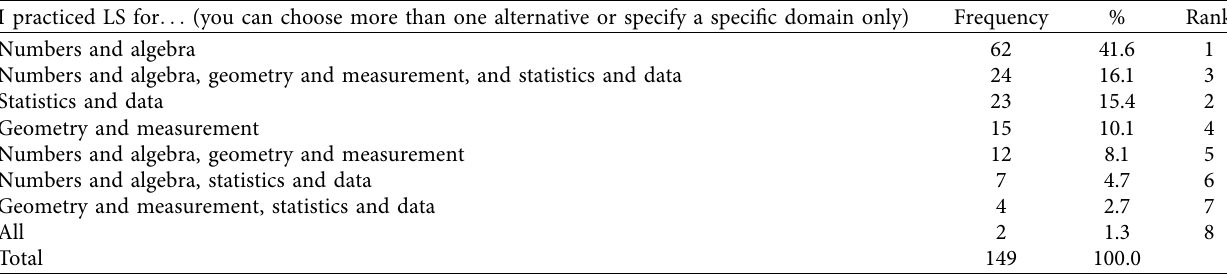
Table 2: Mathematics content domains used for lesson study (LS) practice.